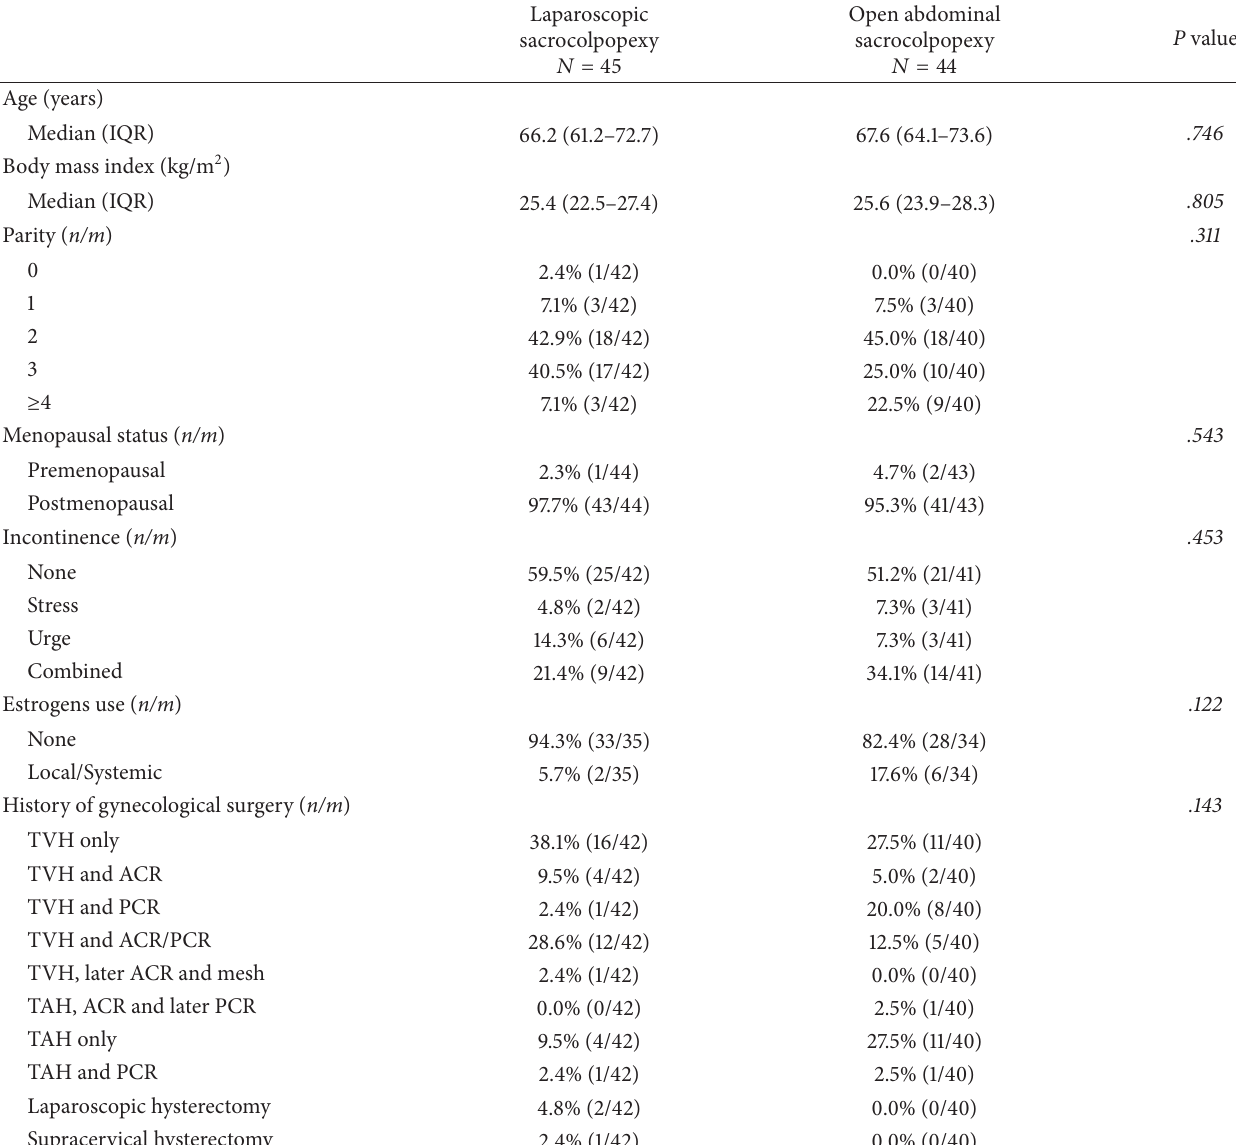
Table 1: Baseline characteristics